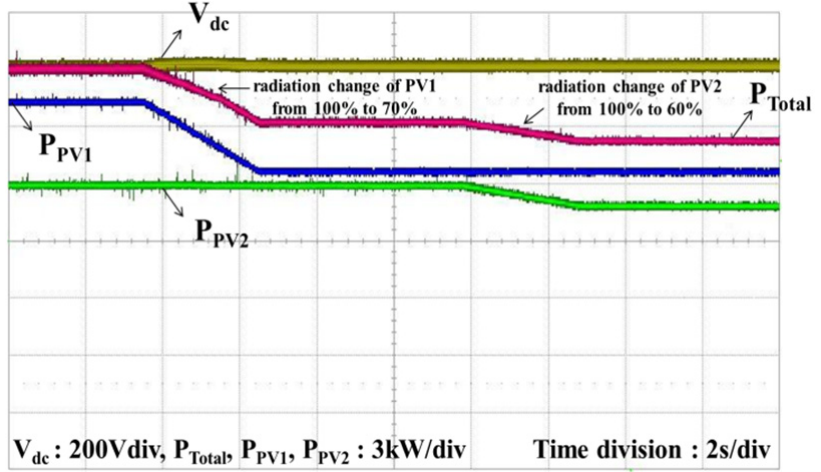
Figure 22. Experimental results for powers of inputs and output when the radiation of PVs is decreased.